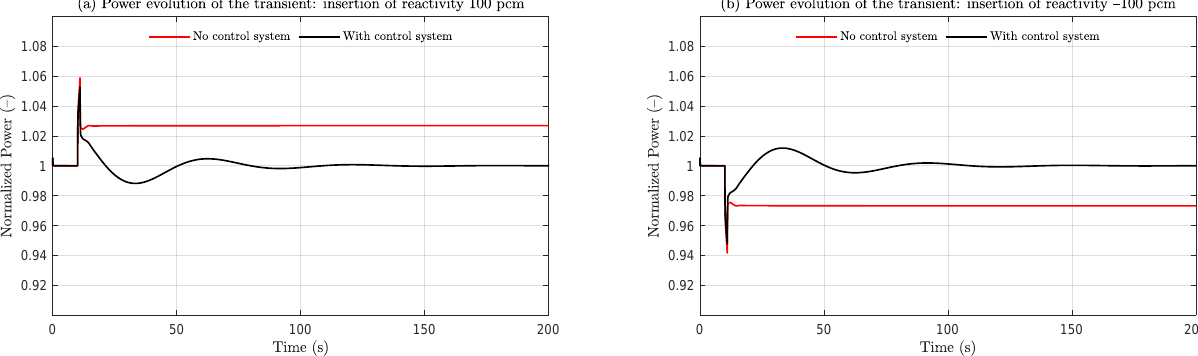
Figure 8. System response of the insertion of reactivity: ( a ) insertion of reactivity at 100 pcm; ( b ) Insertion of reactivity at –100 pcm.